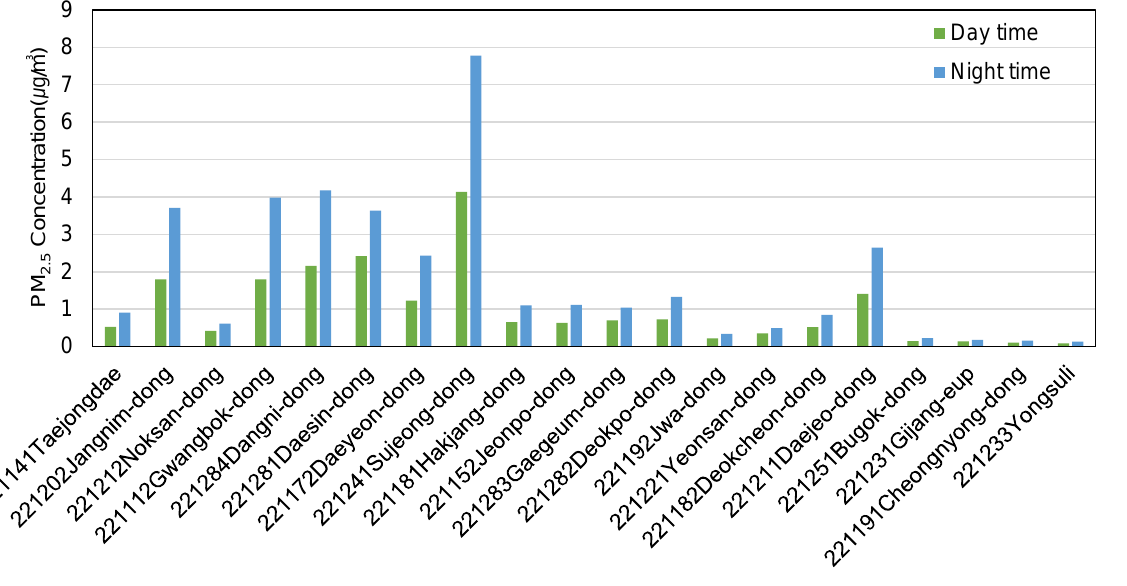
Figure 9. Comparison of PM 2.5 contribution concentrations from ship emissions between daytime and nighttime at air-quality monitoring sites in Busan.